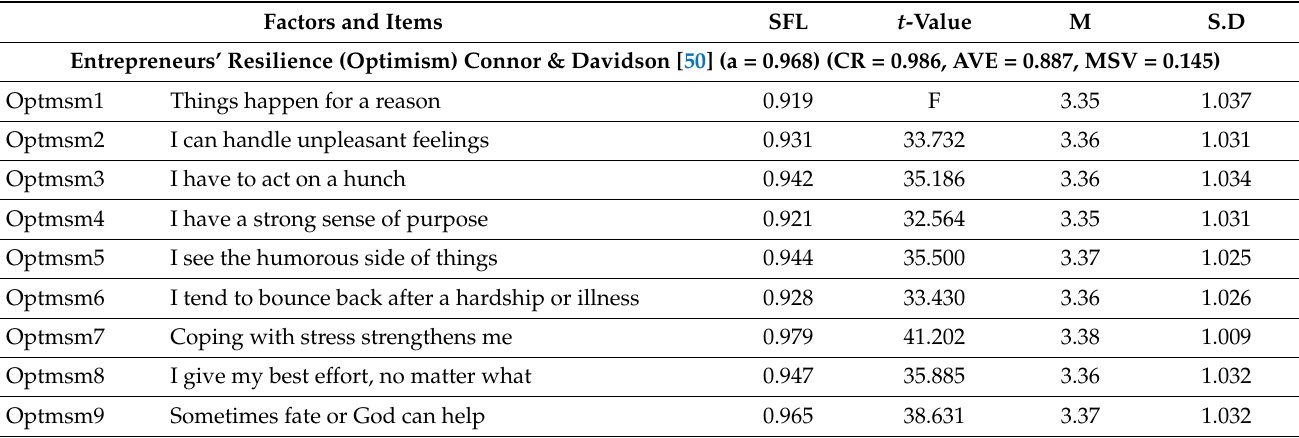
Table 3. Results of first-order CFA M and standard